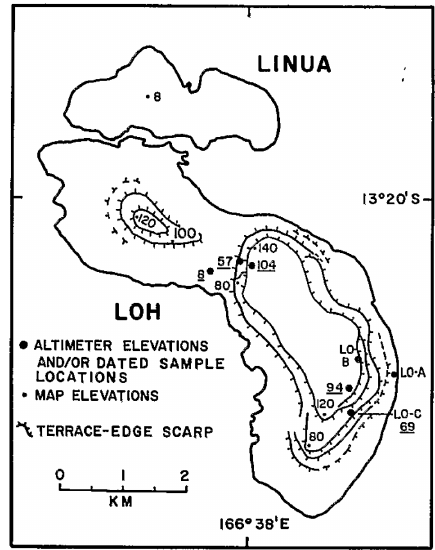
Figure 24. Raised reef terraces on Toga Island (from Taylor et al., 1985). Figure 25. Raised reef terraces on Loh and Linua (from Taylor et